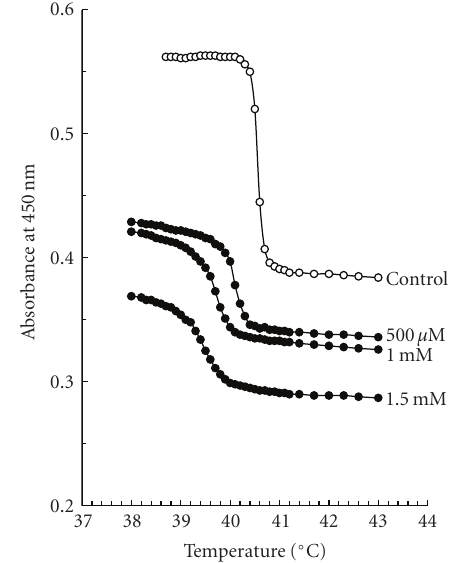
Figure 8: E ff ects of antiplatelet γ -carboline on membrane DPPC phase transition. The absorbance of DPPC liposome suspensions treated with 0, 0.5, 1, or 1.5mM AD γ C was measured at 450 nm with increasing the temperature. Typical traces in multiple mea- surements are